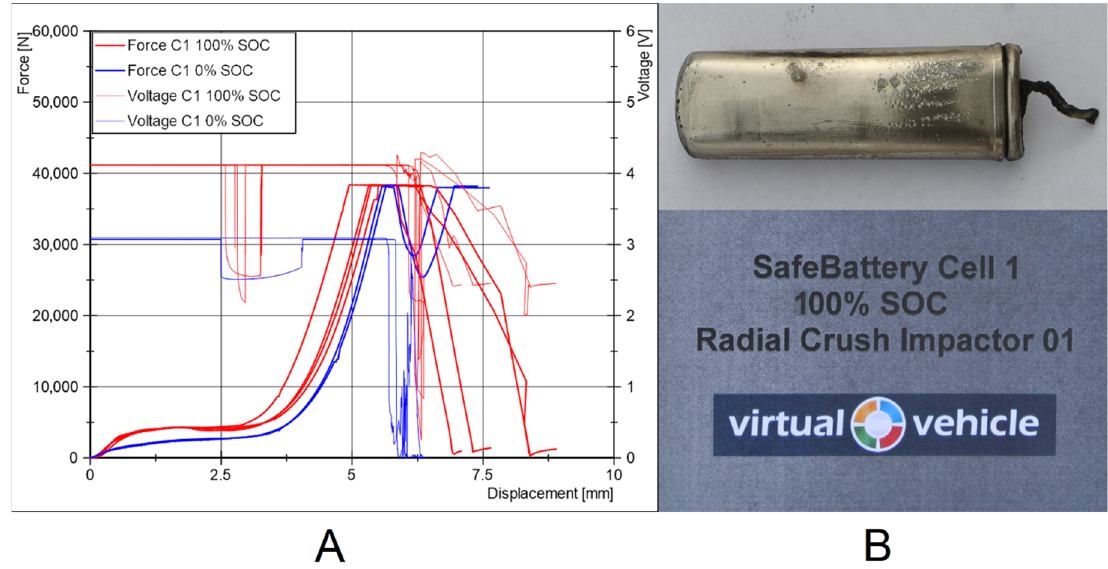
Figure A4. Radial crush C1 (SOC comparison) force over displacement ( A ) and cell specimen after testing ( B ).